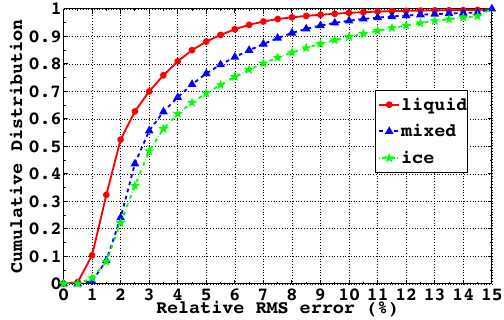
Figure 4. Cumulative distributions of the relative RMS errors for the sigmoidal fits over cloudy ocean using CERES Terra measurements